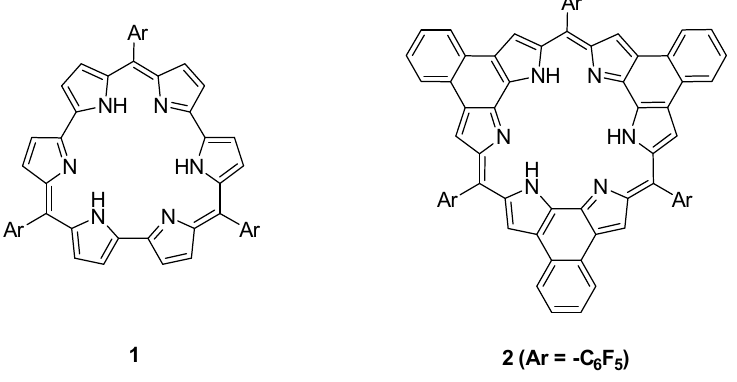
Figure 1. Chemical structures of rosarrin 1 , 2 .